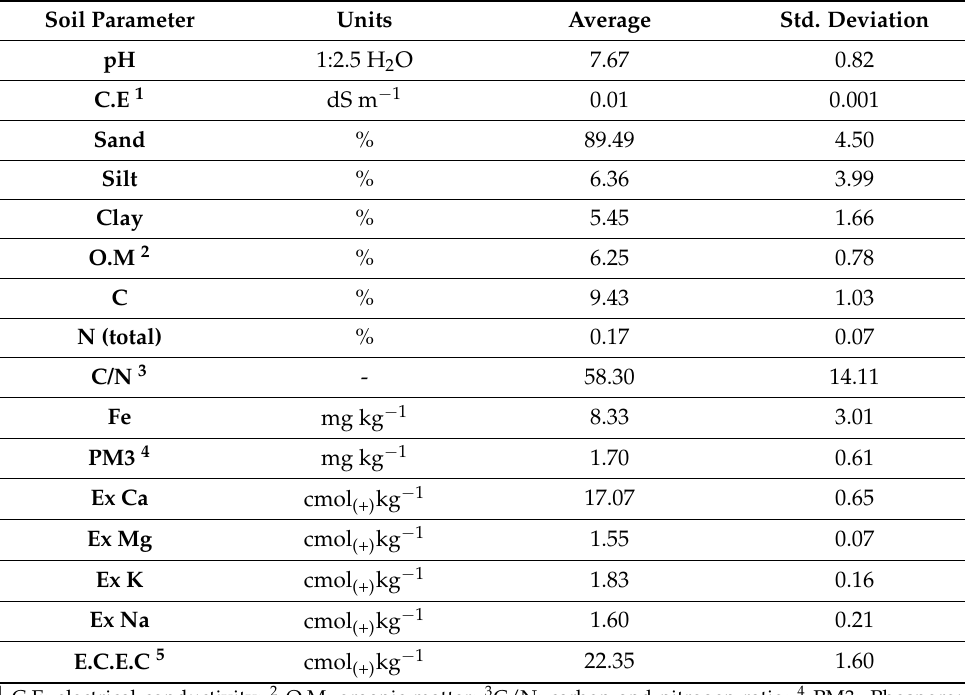
Table 3. Physicochemical characterization of the 21 soil samples studied.